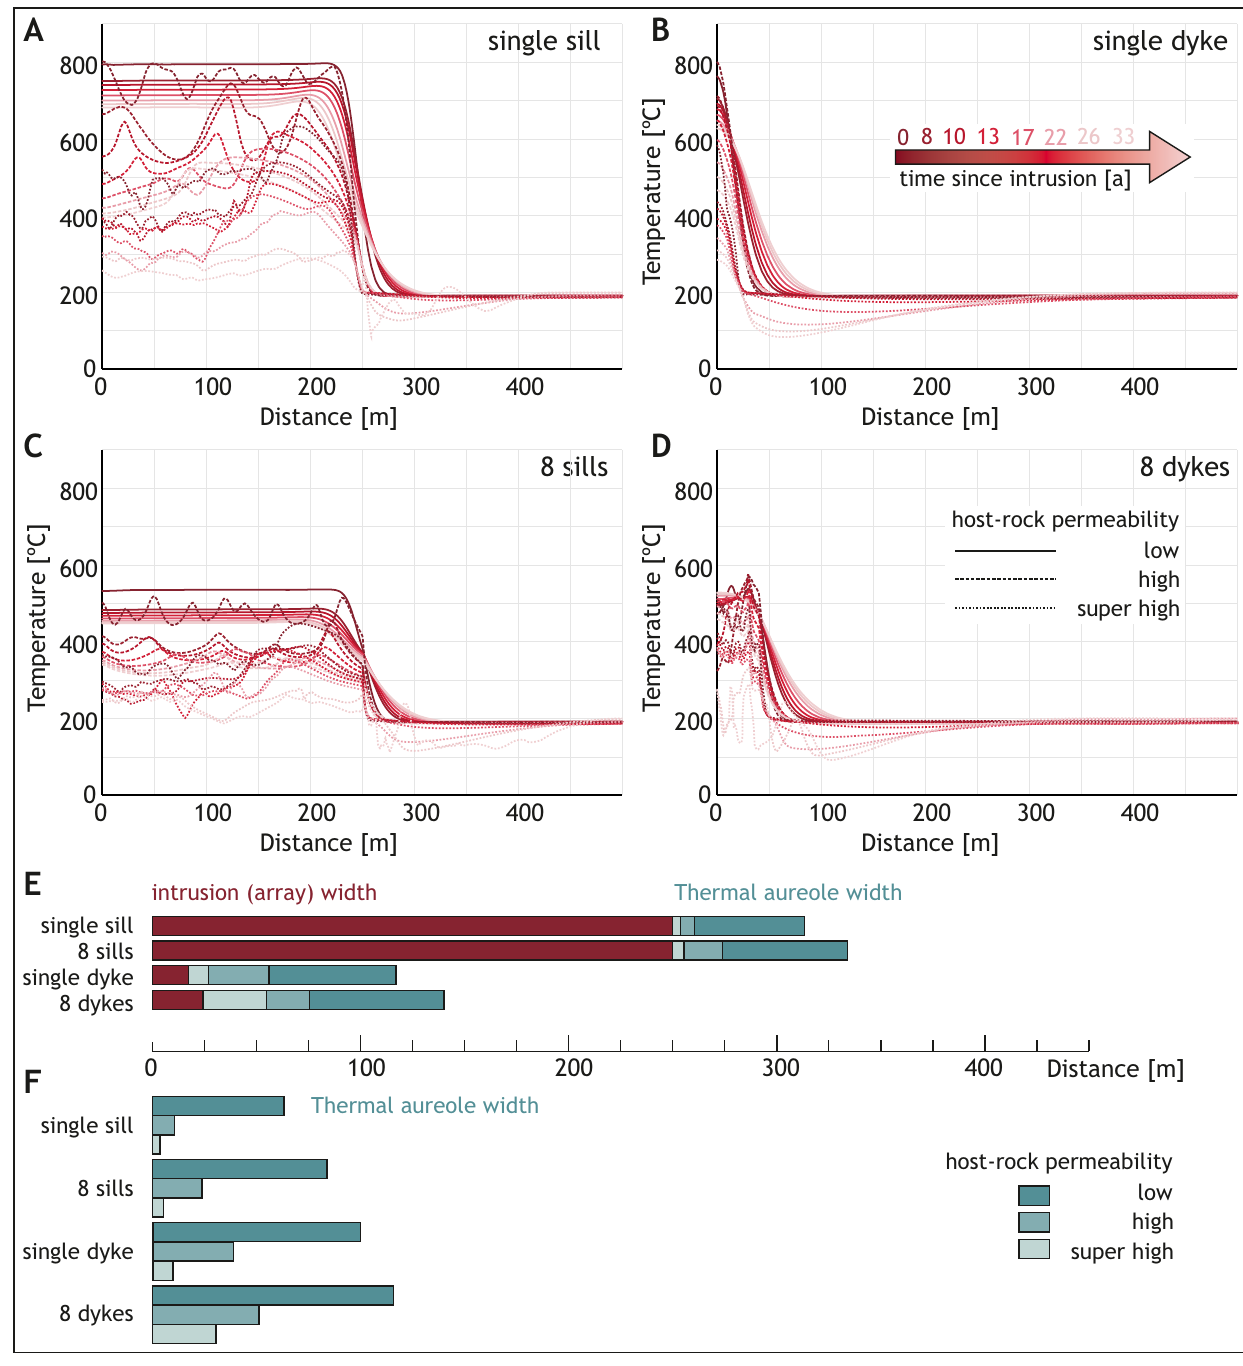
Figure 11: Cooling of the intrusions and heating of the host-rocks along temperature profiles through the models at 1020 m depth during different time steps after intrusion, in years. [A]–[D] Temperature along the profile at different time steps. [E]–[F] The lateral extend of the intrusion(s) and the maximum extend of the area in which temperatures are increased because of the intrusion(s) (i.e. the thermal